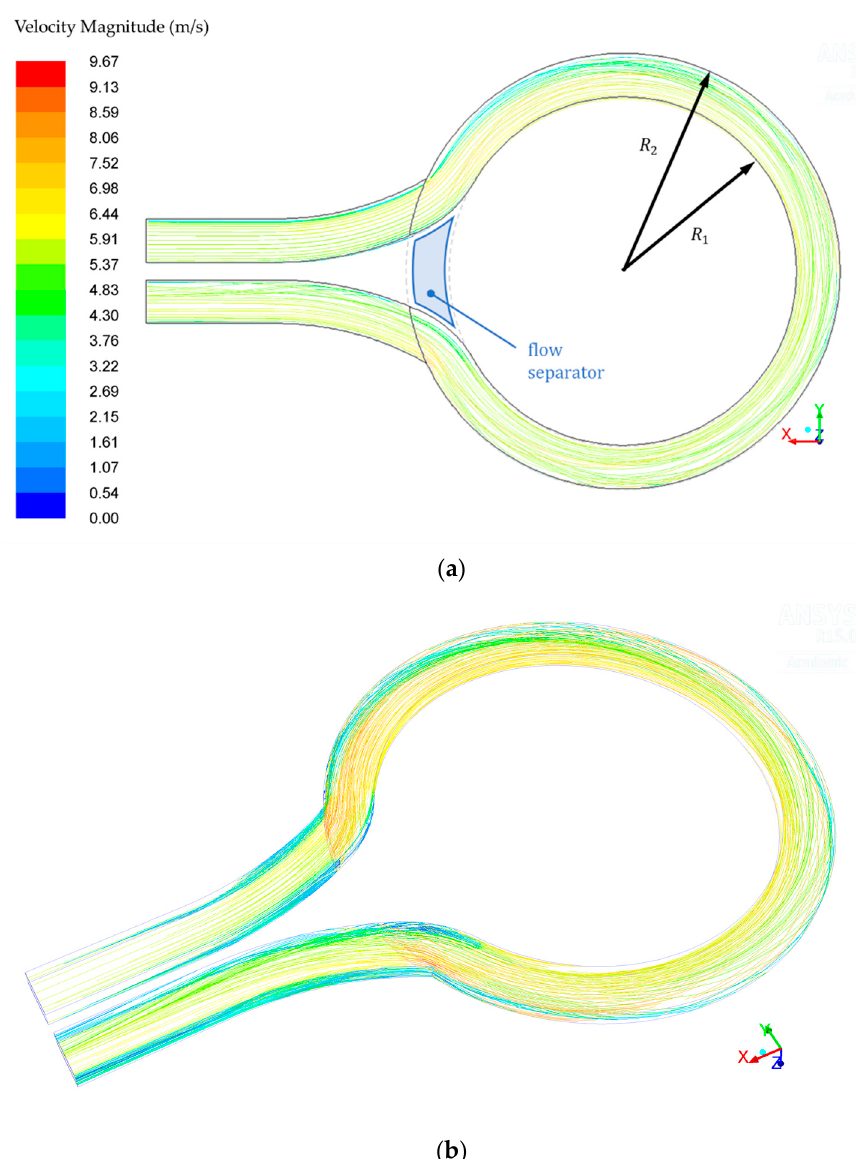
Figure 5. Streamlines in bladeless heart pump in: ( a ) xy plane, ( b ) 3D space. The wall shear stress (WSS) in the rotor is within the range of 46–108 Pa, depicted in Figure 6. There is a small area near the follow separator where the wall shear stress exceeds the defined acceptable value of 150 Pa. The acceptable amount of wall shear stress is achieved in more than 95% of the pump volume [26]. The residence time in the pump is 0.0194 s, while the residence between two disks is 0.0127 s. The exposure residence time in the area with higher values of the wall shear stress is 5 × 10 − 4 s. According to Hellums shear stress-exposure time [26], for exposure residence time of 5 × 10 − 4 s, the acceptable value of shear stress is 700 Pa. The calculated maximum shear stress is 308 Pa, and it is smaller than Hellums.